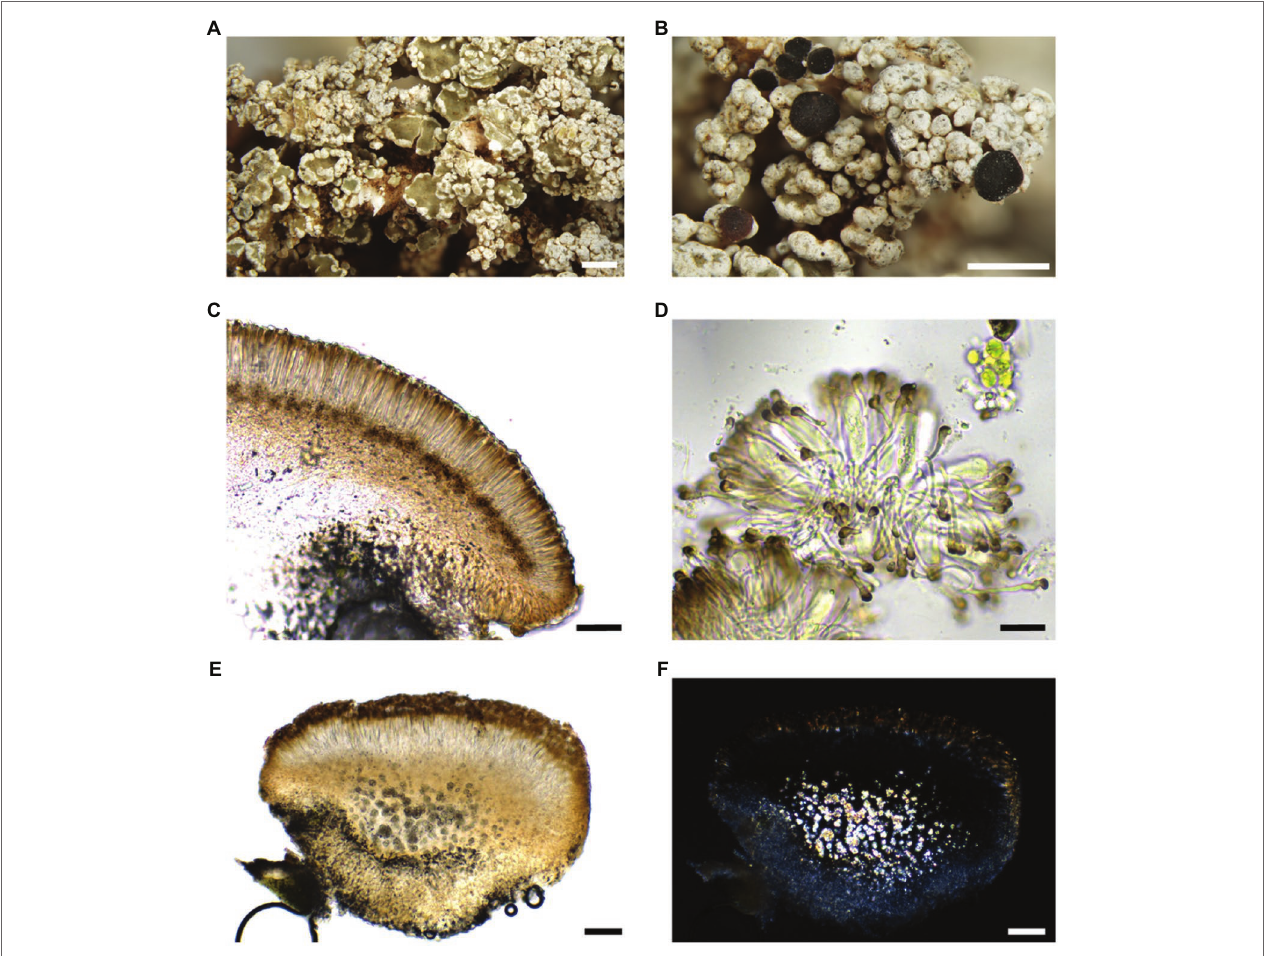
FIGURE 9 | Habitus of Stereocaulon canariense (A–D) and Stereocaulon vesuvianum s. str. (E,F) . (A) Typical peltate phyllocladia, holotype; (B) fertile podetia, holotype; (C) section of an apothecium in water; (D) paraphyses with brown apical cap in KOH; (E) section of an apothecium in water; (F) section of an apothecium in polarized light. Scales: 1 mm (A,B) , 50 μ m (C–F) , 20 μ m (D)